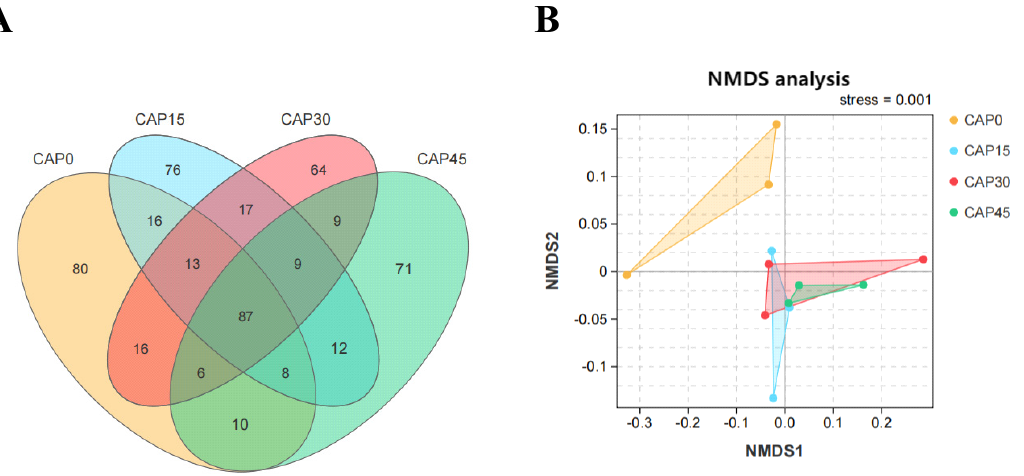
Figure 3. ( A ) Venn diagram. ( B ) Non-metric multidimensional scale analysis (NMDS) based on unweighted uniFrac distance matrix of gut microbiota.